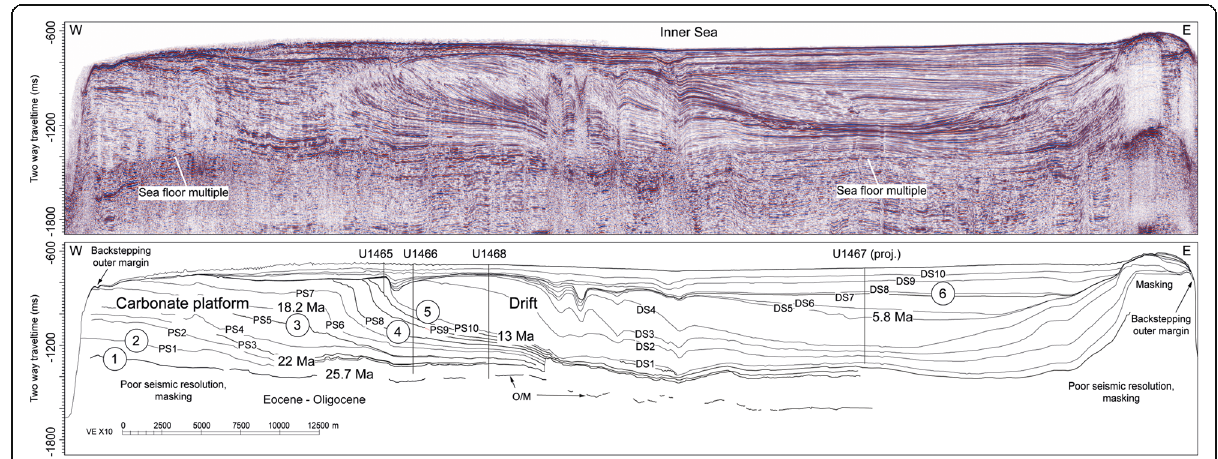
Fig. 2 Seismic line across the Maldives Inner Sea (for location of line see Fig. 1c) with line drawing showing the platform sequence boundaries (PS) and the drift sequence boundaries (DS). Ages of selected horizons are given. For a complete overview of sequence boundary ages see Table 2. Numbers 1 – 6 refer to the turning points of the platform evolution discussed in the